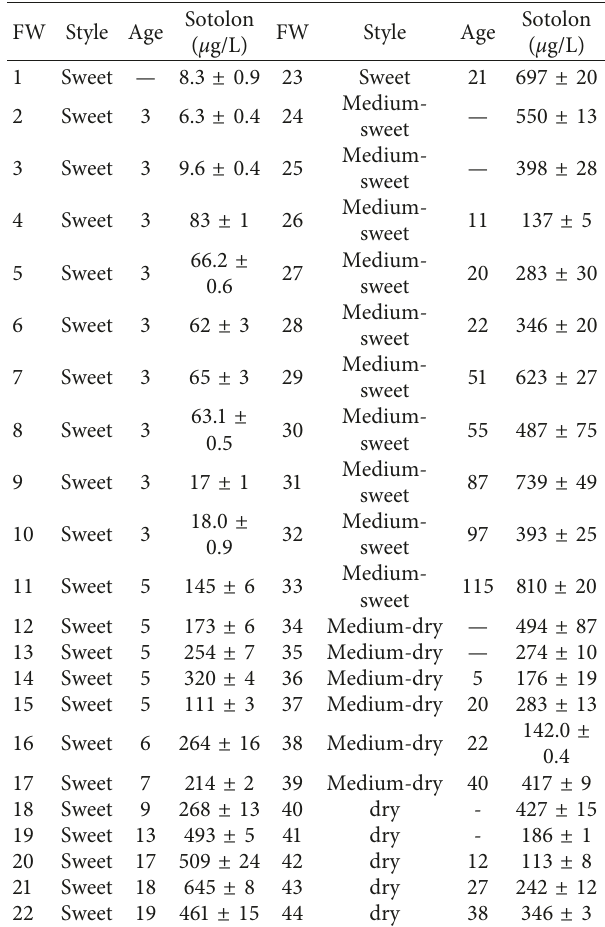
Table 2: Application of the proposed method for the quantification of sotolon (expressed in the mean value ± standard deviation) in 44 fortified wines of different ages and sweetness